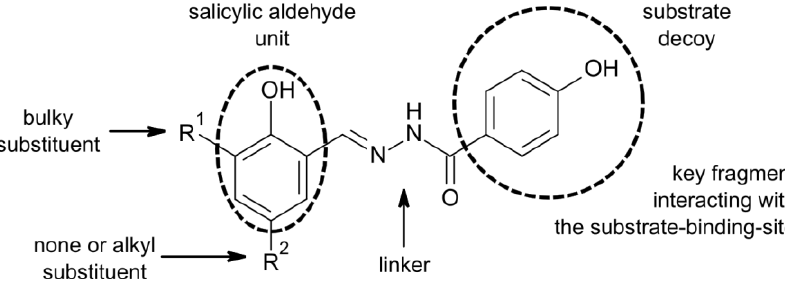
Figure 3. The preferential structure of hydrazide-hydrazones as inhibitors of laccase from T. versicolor . The compounds 4-HBAH and 4-HBA had no inhibitory potency towards the target